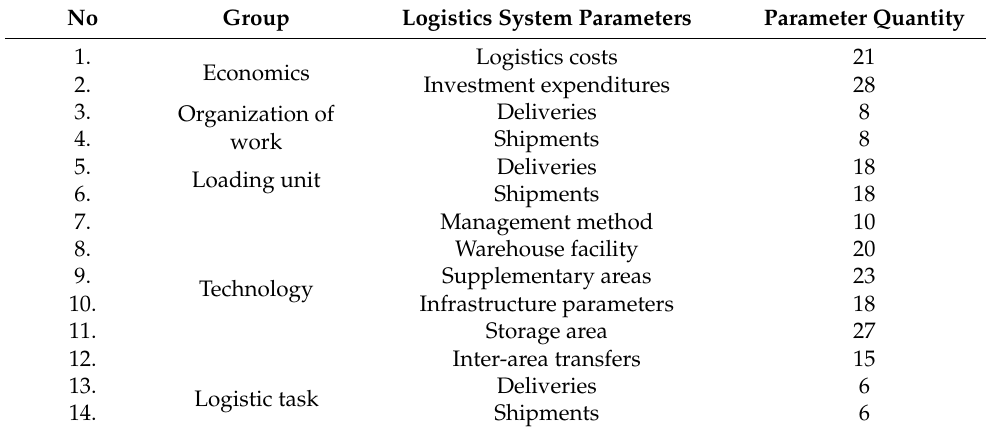
Table 4. Structure of reference